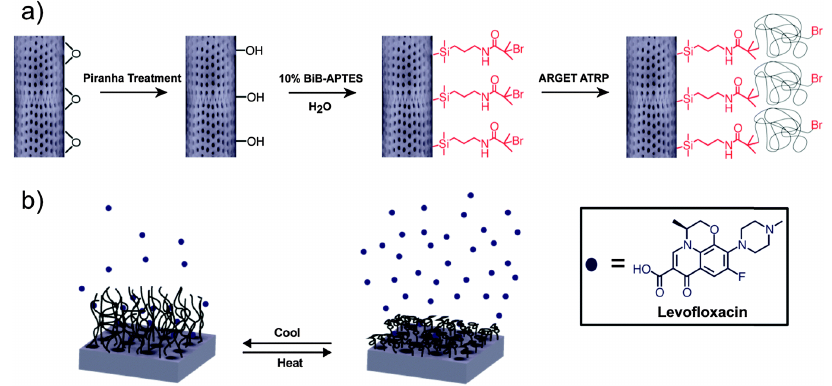
Figure 3. ( a ) Schematic representation of diatom frustule functionalization with thermo-responsive polymer and ( b ) levofloxacin drug release from thermo-responsive polymer-grafted biosilica frustule. Reproduced with permission from [56], Royal Society of Chemistry, 2015.